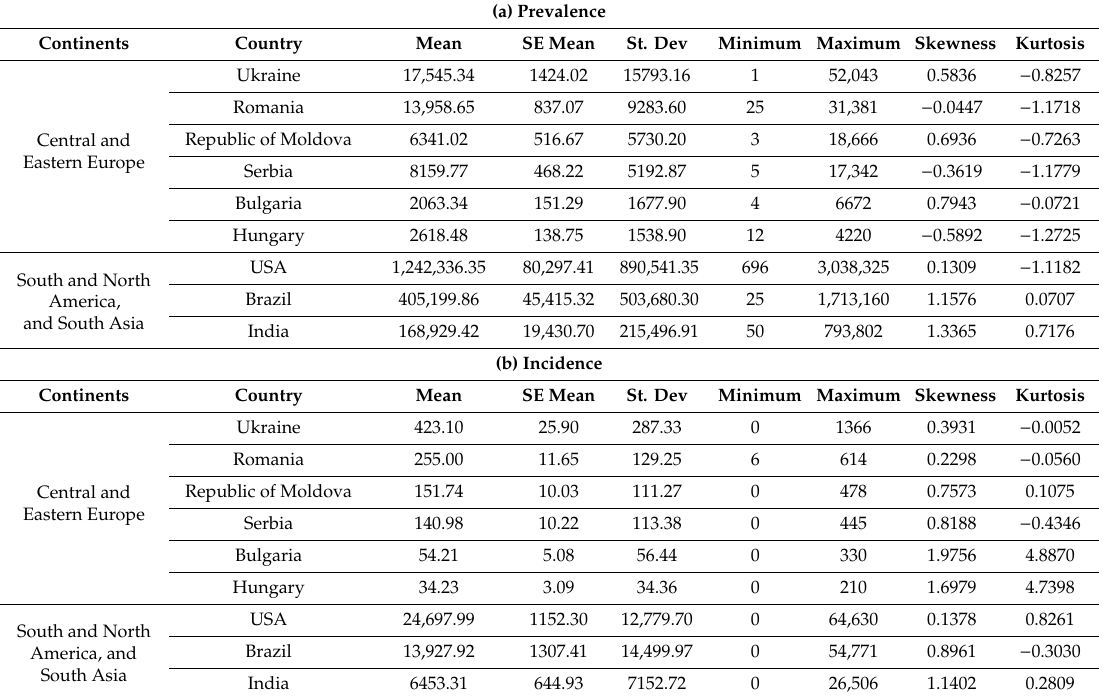
Table 1. Descriptive statistics on the prevalence and incidence of coronavirus (COVID-19) in the established